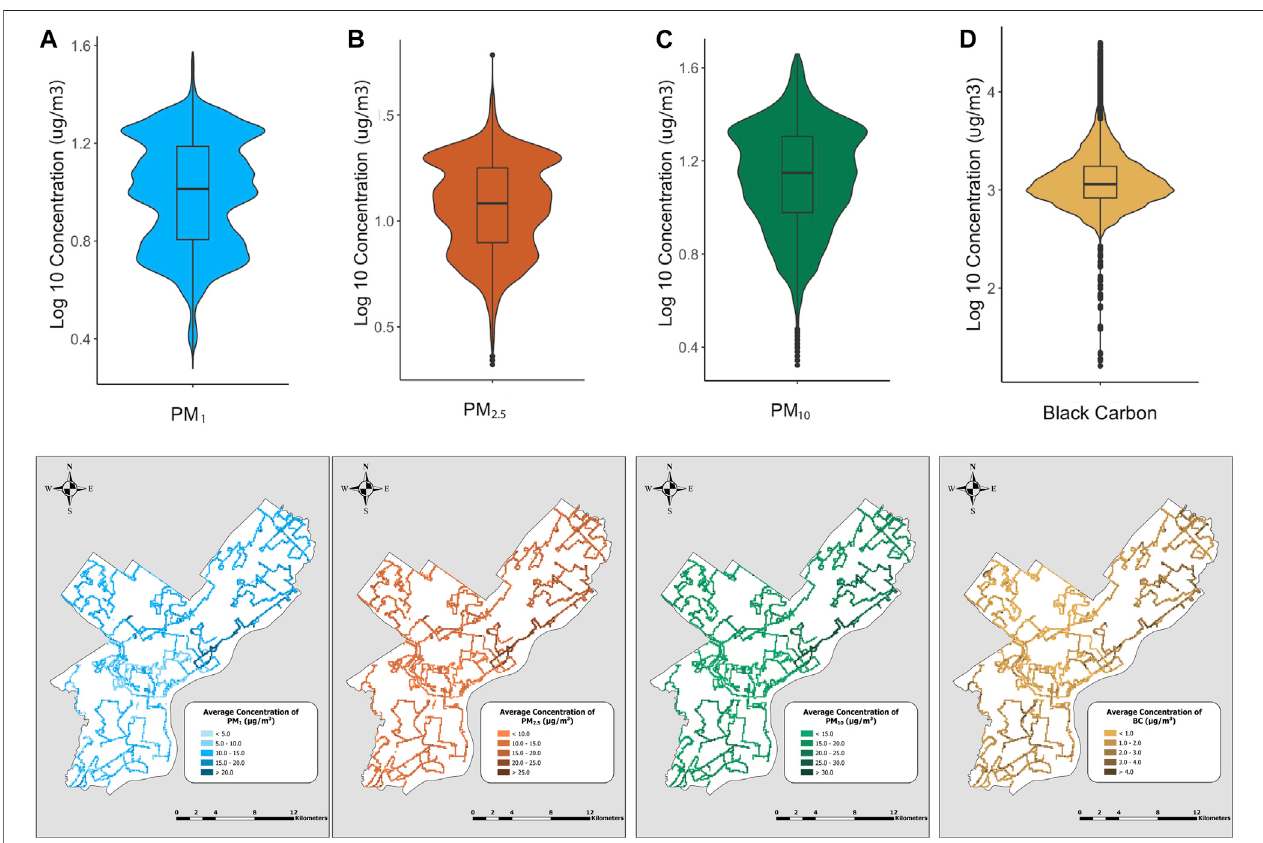
FIGURE 3 | Violin plots and maps for (A) PM 1. (B) PM 2.5. (C) PM 10 , and (D) BC. Violin plots show the distribution of all observed air pollutant concentrations on a log 10 scale, while maps show the overall average concentration of each pollutant in each 120 m 2 cell sampled over the data collection